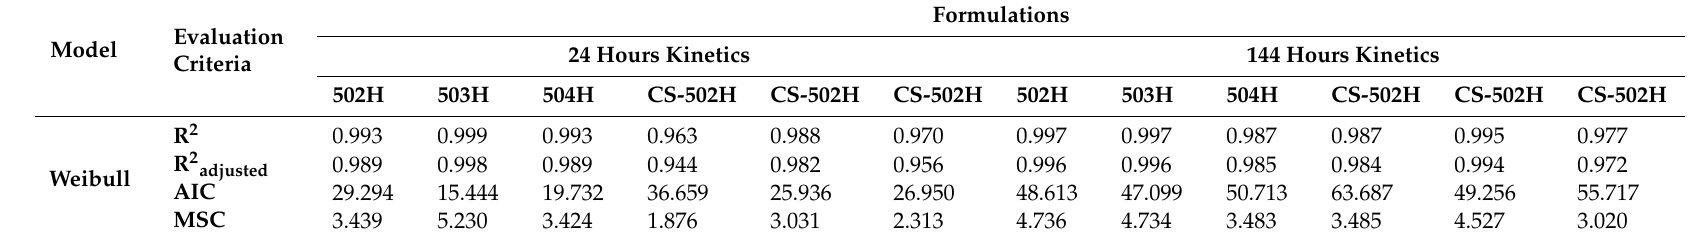
Table 7. Kinetic results for Weibull